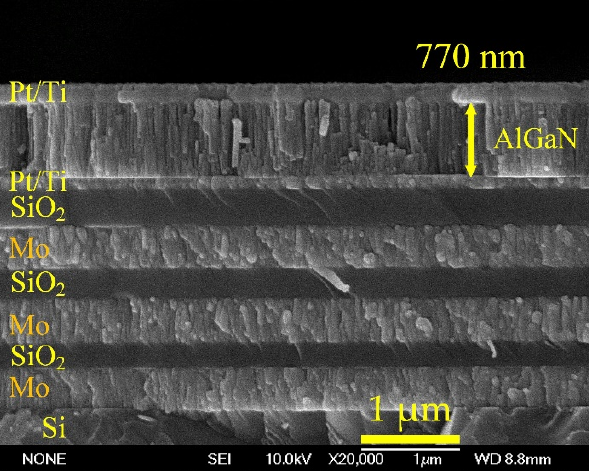
Figure 4. The cross-sectional image of an AlGaN-based SMR device.